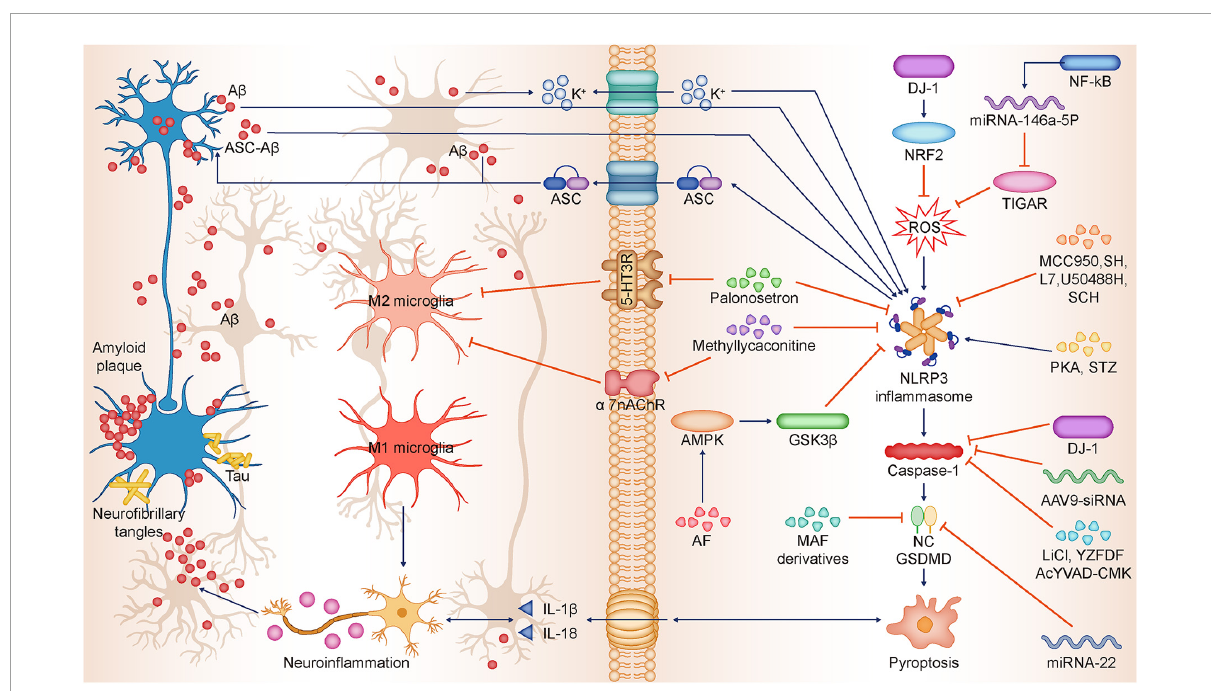
FIGURE2 Relationship between NLRP3-dependent pyroptosis and Alzheimer’s disease. A β deposition and Tau hyperphosphorylation are the main pathological features of AD, and A β and Tau in turn can induce neuronal pyroptosis and neuroinflammation, thus promoting AD progression. A β promotes pyroptosis by activating the NLRP3-caspase-1-GSDMD axis. Besides A β promotes K + efflux, which triggers NLRP3 inflammasome activation and subsequent pyroptosis. ASC can bind to A β to form ASC-A β , which promotes pyroptosis by activating NLRP3 inflammasome. Tau and A β inhibit immunophagocytosis of M2 microglia, promote M1 microglia polarization, and induce sustained neuroinflammation. Palonosetron and Methyllycaconitine inhibit 5-HT3R and α 7-nAChR, respectively, which promotes microglia M2 polarization while inhibiting NLRP3 inflammasome expression. NF- κ B activates and promotes miR-146a-5p transcription, which inhibits TIGAR expression, ultimately leading to ROS occurrence and promoting NLRP3 activation. DJ-1 promotes nuclear translocation of NRF2 and inhibits ROS production, thereby suppressing NLRP3 activation. FSK, STZ promote NLRP3 inflammasome expression. MCC950, SH, L7, U50488H, SCH inhibit NLRP3 and attenuate neuronal pyroptosis. AF activates AMPK/GSK3 β pathway, thus downregulating NLRP3 expression. LiCl, YZFDF, AcYVAD-CMK, AAV9-siRNA inhibit caspase-1 activation, thereby inhibiting neuronal pyroptosis. Mafenide derivatives, miRNA-22 inhibit GSDMD, thereby inhibiting neuronal pyroptosis. A β , β -amyloid; Tau, Tau protein; AD, Alzheimer’s disease; NLRP3, NLR family pyrin domain-containing 3; ASC, Apoptosis-associated speck-like Protein; ASC-A β , Complex ASC-A β ; NF- κ B, Nuclear factor kappa β ; TIGAR, TP53-induced glycolysis and apoptosis regulator; ROS, Reactive oxygen species; DJ-1, DJ-1 gene; NRF2, Nuclear factor E2-related factor 2; FSK, Forskolin; STZ, Streptozotocin; MCC950, NLRP3 inflammasome inhibitor; SH, Sodium houttuyfonate; L7, N-salicyloyl tryptamine derivatives; U50488H, k-opioid receptor agonist; SCH, Schisandrin; AF, Amentoflavone; AMPK, AMP-activated protein kinase; GSK3 β , Glycogen synthase